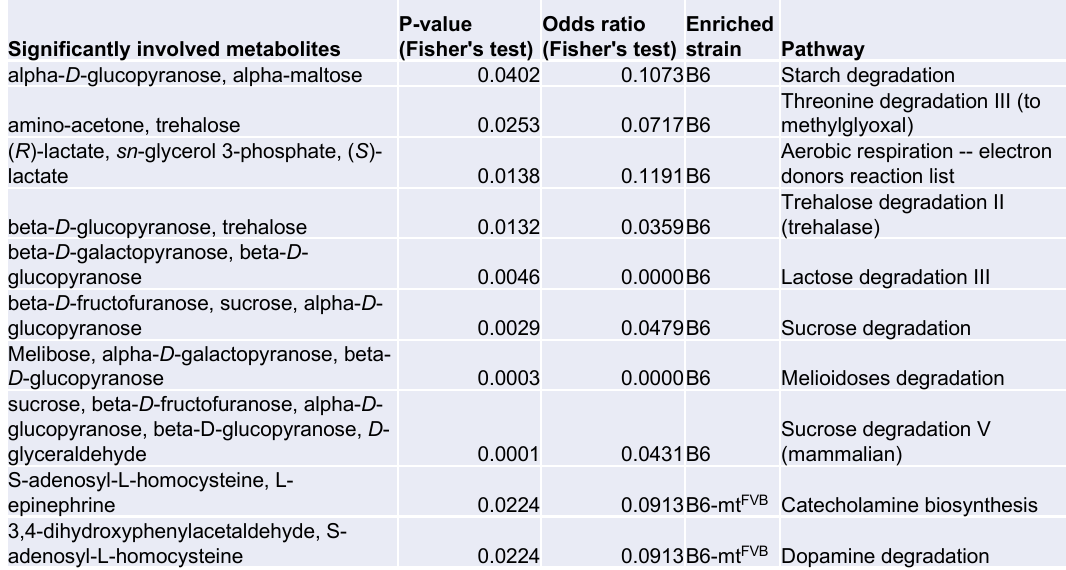
Figure 3. Mice carrying the m.7778G > T in the mt-Atp8 gene demonstrated differential levels of short chain fatty acids and other metabolites compared to wild-type mice. ( A ) L-carnitine bound short chain fatty acids (acetylate, propionate, and butylate) were measured in different tissues (liver, skin, lymph nodes, and thymus) from B6-mt FVB and B6 mice, by the targeted metabolomics approach. Acetyl-L-carnitine levels in the liver tissue from B6-mt FVB were significantly higher than those from B6 mice (adj. p = 0.0008; multiple t test). Propionyl-L-carnitine levels were significantly higher in the liver, skin, and lymph node samples from B6-mt FVB mice compared to those from B6 mice (adj. p = 0.0001, liver and skin; adj. p = 0.0008, lymph node; multiple t test). Butyryl-L-carnitine levels in the liver and skin samples from B6-mt FVB mice were significantly higher than those from B6 mice (adj. p = 0.0463 and adj. p = 0.0205, respectively; multiple t test). LN: lymph nodes. N = 10 (5 males and 5 females)/strain. ( B ) An untargeted metabolomics analysis was performed in liver samples obtained from B6-mt FVB and B6 mice using high-resolution ultra-high performance liquid chromatography tandem mass spectrometry (UHPLC-MS/MS). The volcano plot demonstrates the differentially identified metabolites between B6-mt FVB and B6 mice. The y -axis indicates p value determined by Wilcoxon test, and the x -axis demonstrates the calculated log fold changes of the mean peak-area-values between the strains. N = 16 (6 males and 10 females)/strain, 2 to 4 months old. ( C ) Pathway enrichment analysis of the liver untargeted metabolomics dataset in Figure 3B was performed. The list shows metabolite hits in identified differentially involved metabolic pathways between B6-mt FVB and B6 mice. Two pathways involving adenosyl- L-homocysteine was significantly enriched in B6-mt FVB mice compared with B6 mice, while sugar degradation pathways were significantly less in B6-mt FVB than B6